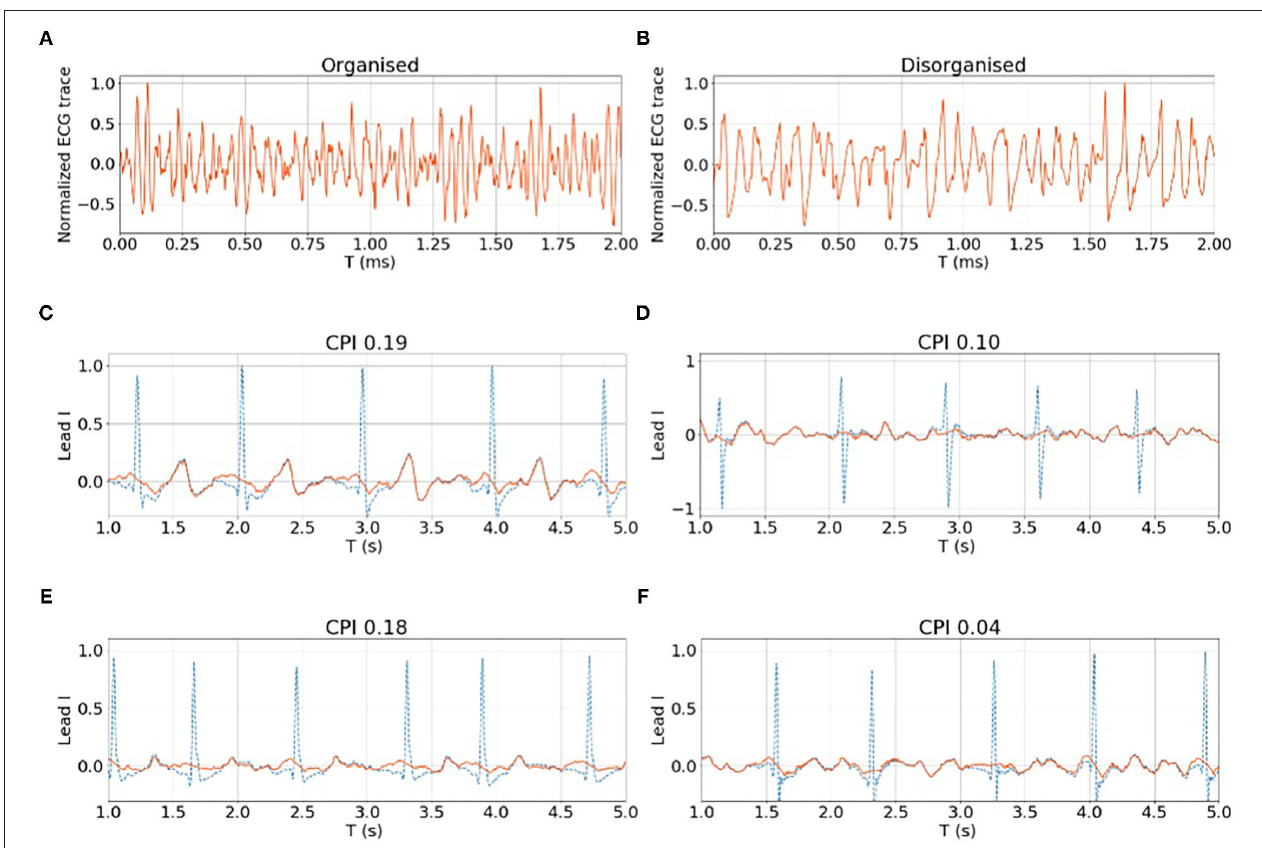
FIGURE 8 | (A,B) show examples of organised and disorganised rat VF ECG. (C–F) shows examples of clinical AF ECG with different CPI levels calculated from the corresponding EGM data. For both rat and clinical data, it is difficult to differentiate the organised and disorganised data by visual evaluation